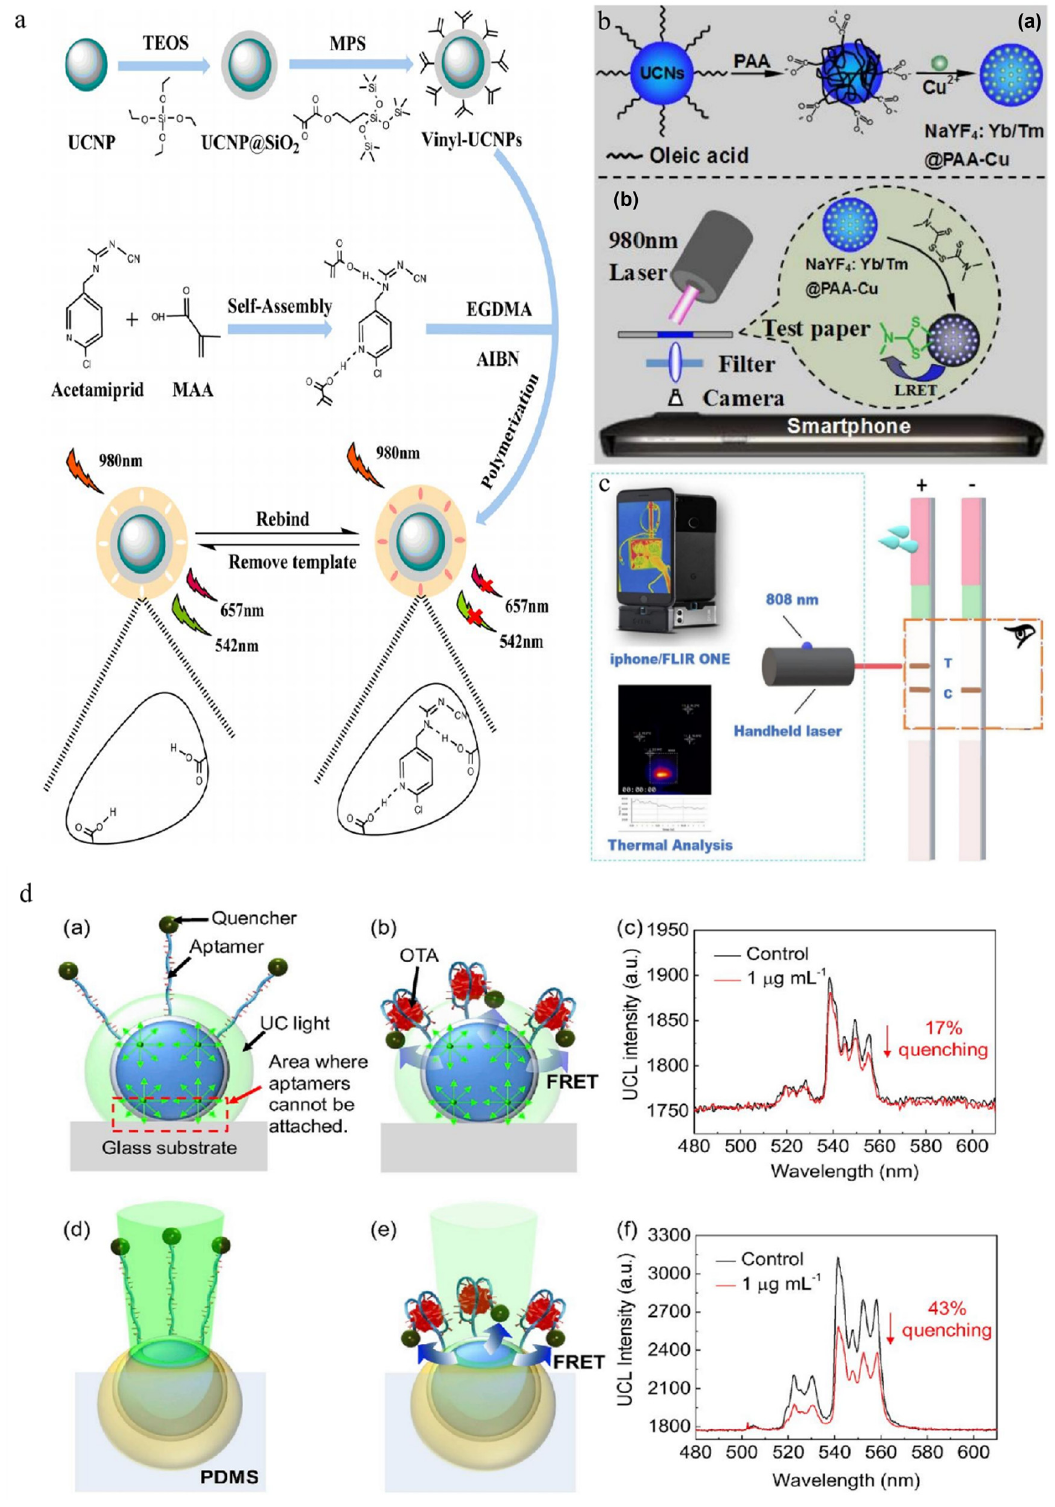
Figure 4: Schematic diagram of upconversion nanotechnology for detection of agricultural and veterinary drug residues, mycotoxins, and antibiotics: ( a ) UCNPs@MIP, the preparation and imprinting process of the product are illustrated [ 123 ] ; ( b ) schematic diagram of detection principle of upconversion test paper for thiram [ 124 ] ; ( c ) schematic diagram of nor fl oxacin detection principle [ 129 ] ; ( d ) based on FRET - induced quenching, the schematic diagram of OTA detection using aptamer ( labeled with quenchant ) functionalized bare UCNPs on glass substrate [ 119 ]